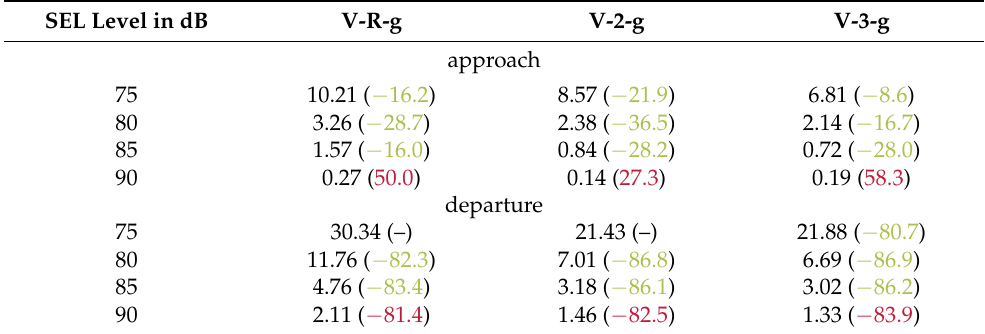
Figure 14. L A , max level 1000m sideline during departure ( neo ) with and without applied shielding. Table 8. Sizes of isocontour areas in km 2 , neo . Relative difference to ceo counterparts in brackets (advantageous change: green, disadvantageous change: red).